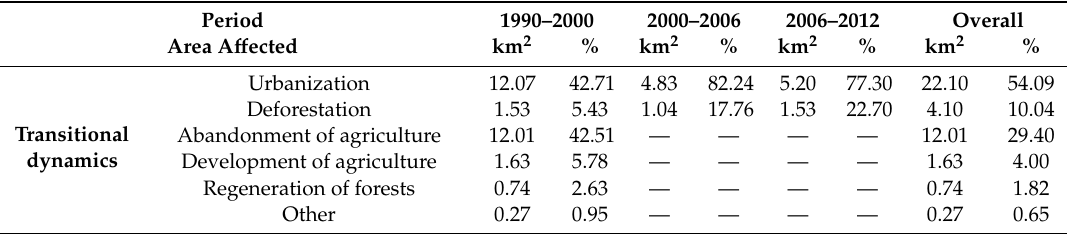
Table 5. Main transitional dynamics within the Romanian shoreline between 1990 and 2012. For each transitional dynamic, the area a ff ected was computed as absolute size (column labeled “km 2 ”), and share of the total area of the shoreline (column labeled